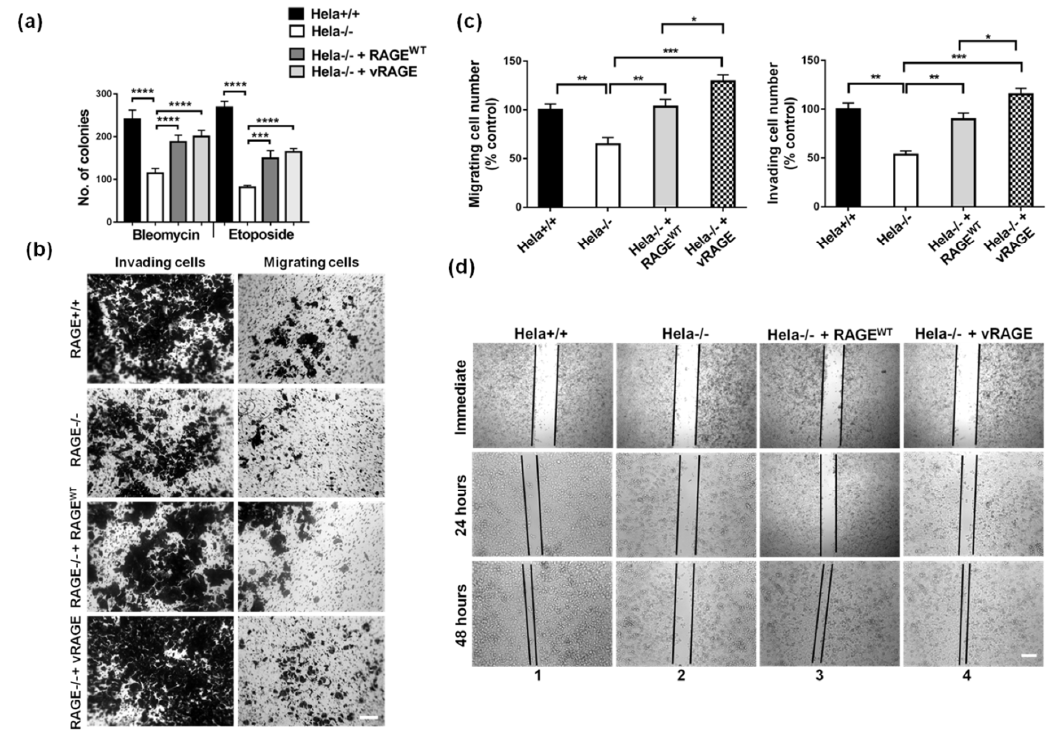
Figure 6. vRAGE is associated with radiomimetic drug resistance, migration, invasion and wound healing. ( a ) Quantitative presentation of the total number of colonies from Hela +/+ , Hela −/− , Hela −/− + RAGE WT , or Hela −/− + vRAGE cells surviving after bleomycin (30 µg/mL for 1 h) or etoposide (2.5 µM for 1 h) induced DNA damage. The colonies were attained after 10 days of DNA damage recovery. ( n = 6, mean ± SD, ***: p < 0.001, ****: p ≤ 0.0001). ( b ) Representative images of the Hela cells migrated or invaded in the transwell migration assay. The migrated cells were stained with Crystal violet (Scale 40 µ m). ( c ) The quantitative analysis of the percentage (%) of the indicated Hela cells migrated (left) or invaded (right) in the transwell assay described in figure (Figure 6b). The migrated cells were stained with crystal violet and counted manually. ( n = 3, mean ± SD, ns: non-significant, *: p < 0.05; **: p < 0.01; ***: p < 0.001). ( d ) The representative images of Hela cell migration in the wound healing assay directly after wounding, at 24 or 48 h after the induction of a wound (Scale 40 µ